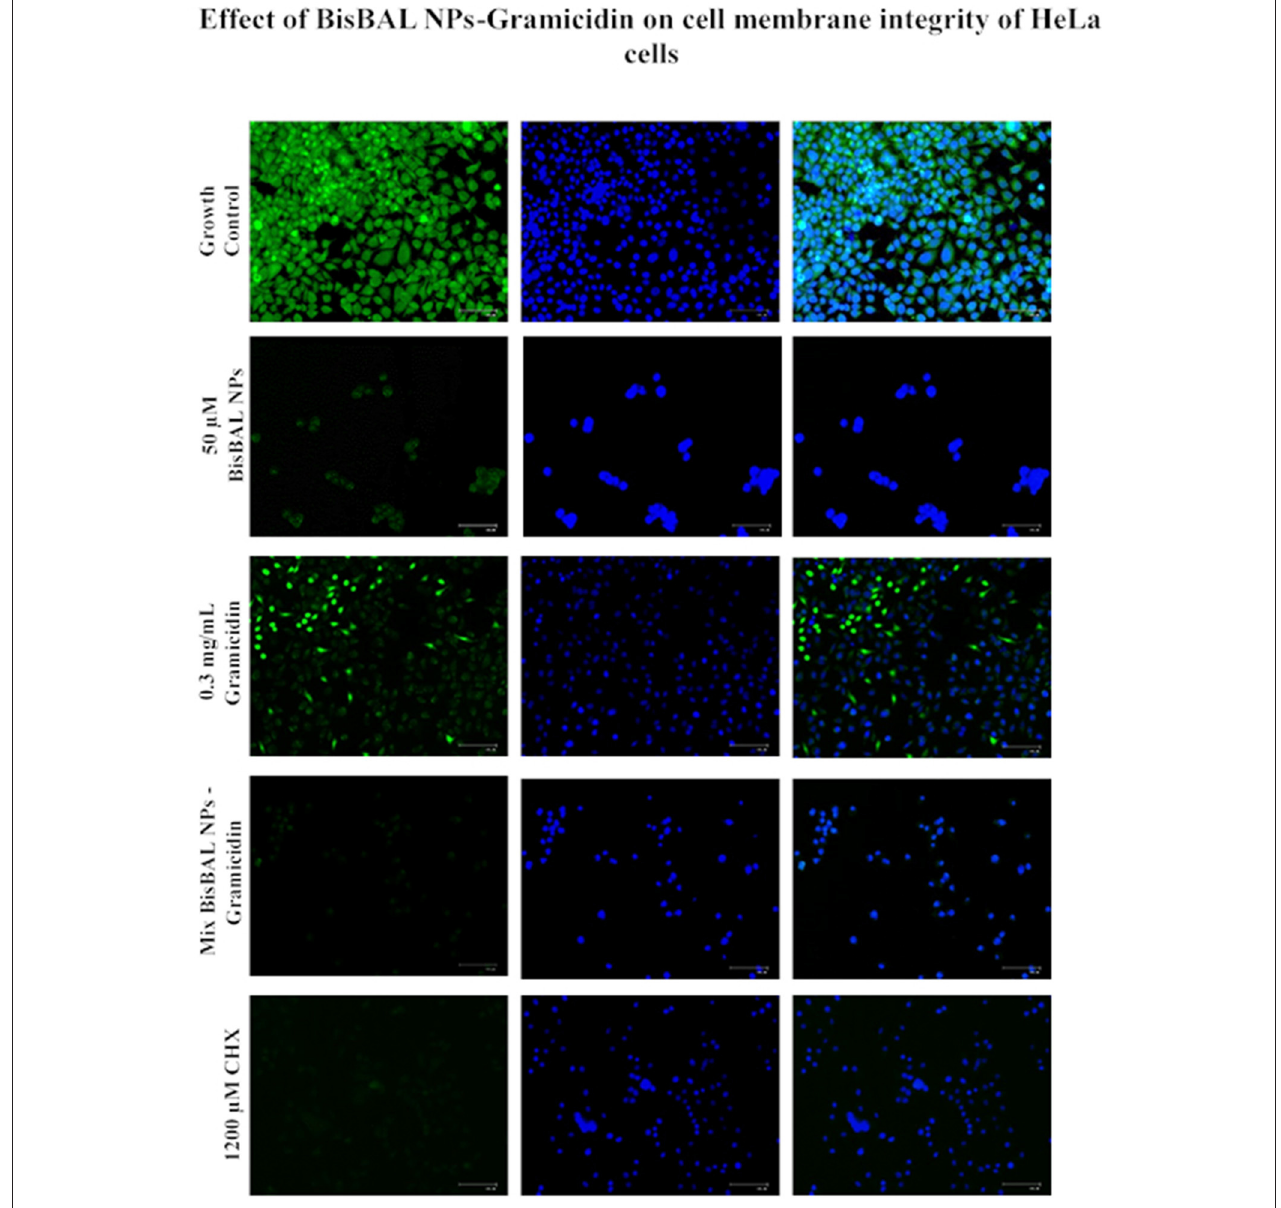
FIGURE 7 | Cell membrane permeability of HeLA cells was evaluated after treatment with gramicidin, BisBAL NPs or both by Calcein AM and fluorescence microscopy. A 24-h exposure to 0.3 mg/mL gramicidin, 50 µ M BisBAL NPs, or a BisBAL NPs/gramicidin mixture on HeLa cell monolayers was evaluated by calcein AM assay. Untreated cells were used as growth control and 1,200 µ M chlorhexidine (CHX) served as a positive control. Bar indicates 125 µ m.